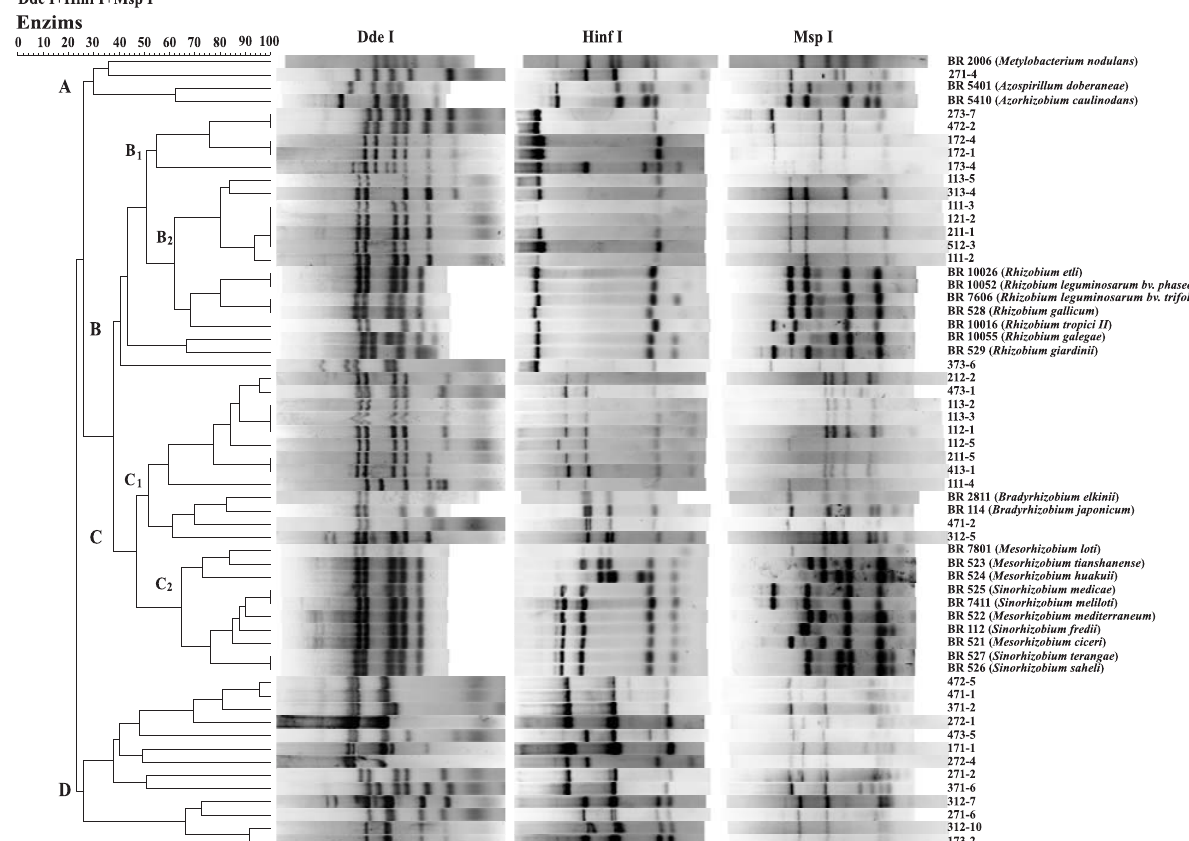
Figure 3. Composite dendrogram of cowpea isolates from two soil samples and rhizobium strains cleaved with the restriction enzymes Dde I, Hinf I and Msp